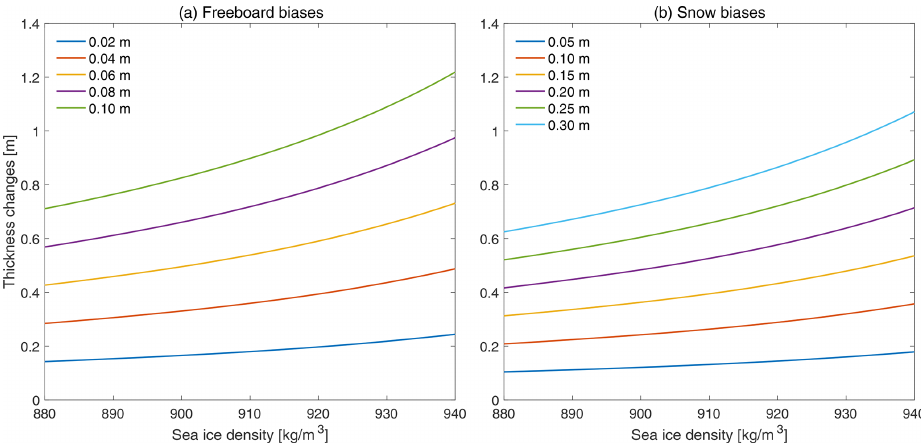
Figure 10. Sensitivity of sea ice thickness changes to sea ice freeboard biases and snow depth biases as a function of sea ice density. (a) SIT changes computed with Eq. (1) for different sea ice freeboard biases (0.02 to 0.1m). (b) Similar to (a) but computed for different snow depth biases (0.05 to